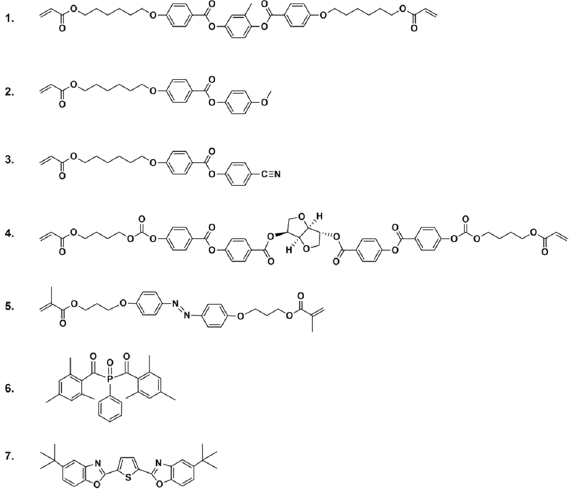
Figure 6. Applied materials. Liquid crystal monomers (1–3), polymerizable chiral dopant (4), polymerizable azobenzene (5), photoinitiator (6), fluorescent dye